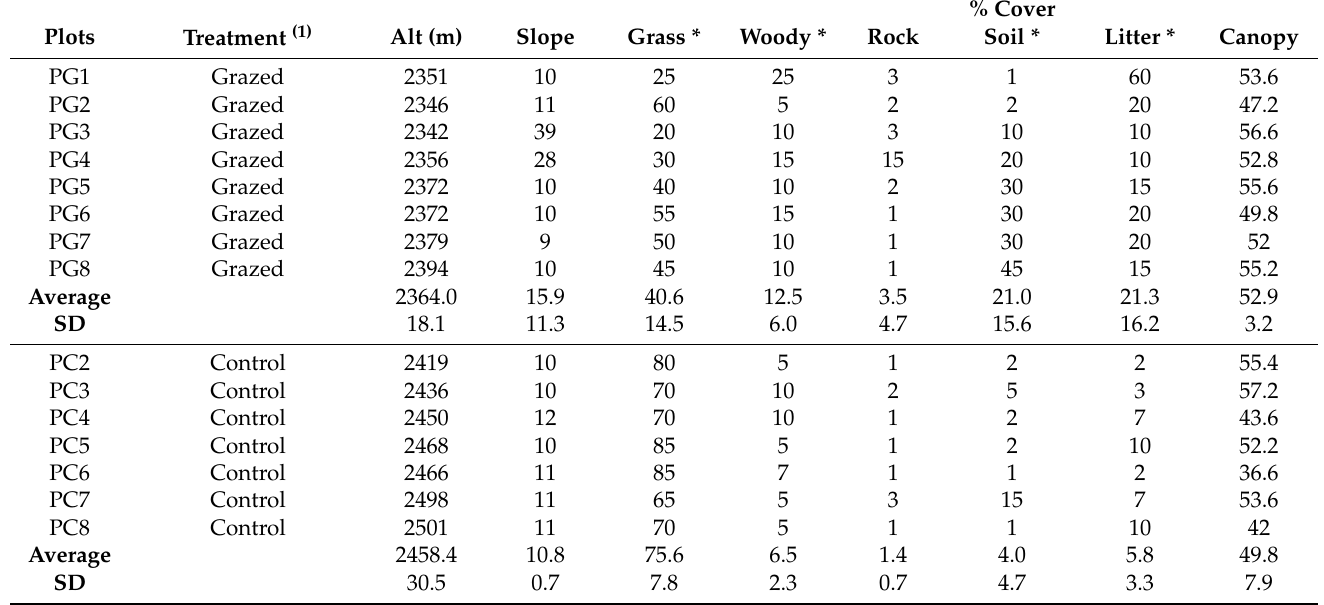
Table 1. General abiotic information of experimental plots and soil nutrients and characteristics of experimental plots. The values (cid:48) average (Avg) and standard deviations (Std) for grazed and control plots are